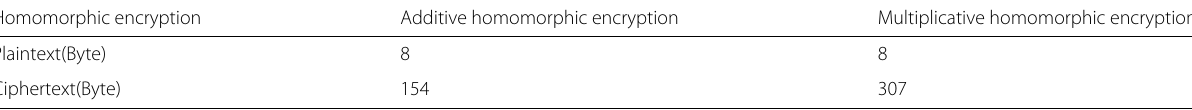
Table 6 Message size of multiplication and addition using homomorphic encryption